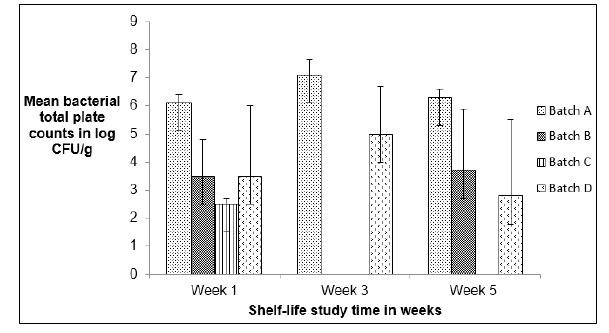
Total bacterial plate counts (log CFU/g) obtained for modified (Batches B, C, D) and traditional (Batch A) motoho over a 5-week shelf-life study.